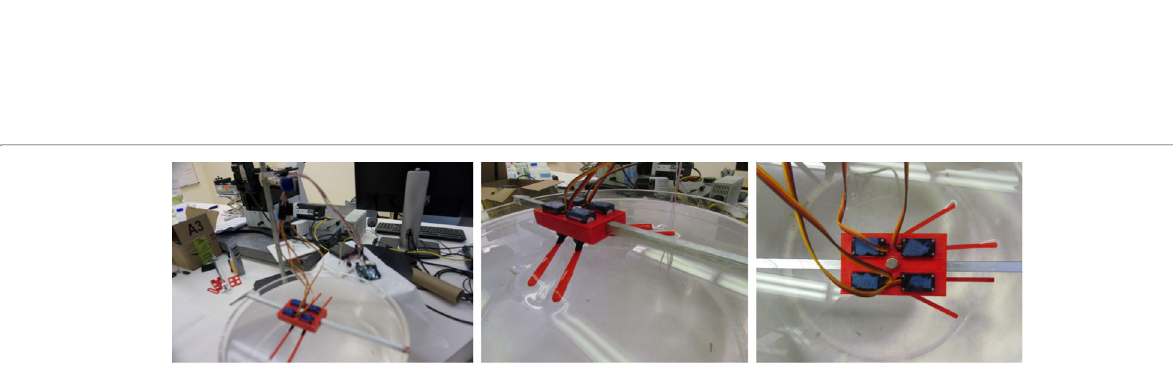
Fig. 25 Set-up of the experiment. The dimensions of the robotics copepod are as follows. The body is a 75 by 43 mm rectangle with four 13 by 23 mm rectangles to fit the motors. The body is 12 mm high with a 10 by 10 hole to fit the rail. Each leg measures 69 mm in length and as a cross section is 9 mm